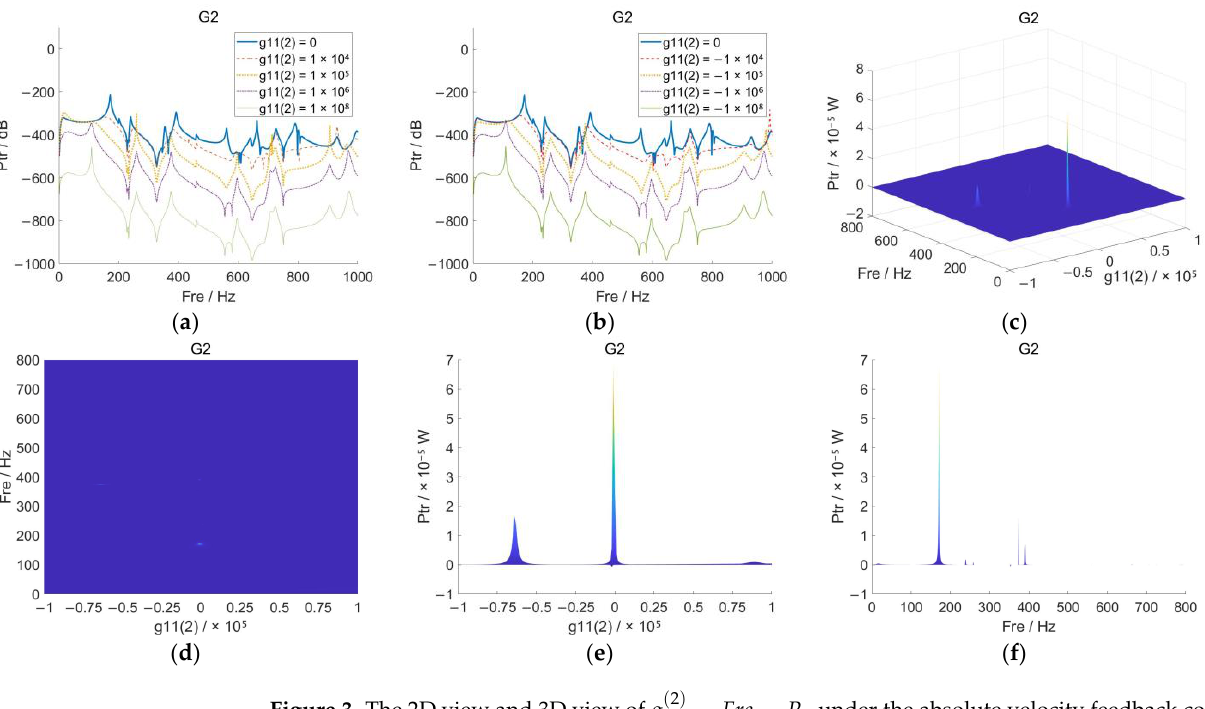
Figure 2. The 2D view and 3D view of ( ) 1 control method ( ( ) ( , the step size is set to 1 × 10 7 ): ( a ) comparison of ( ) 1 0 g  ; ( b ) comparison of 11